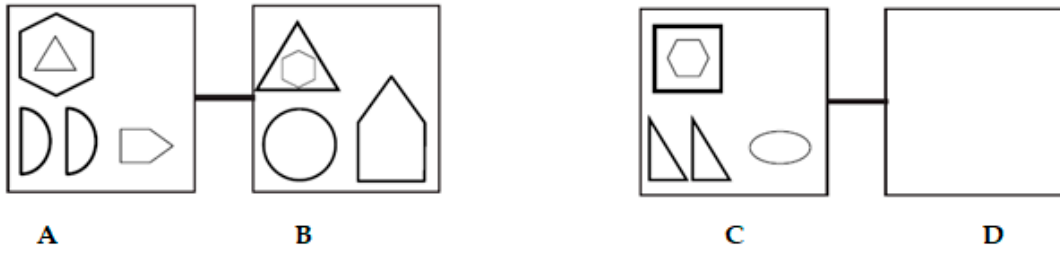
Figure 1. Example of a difficult analogy item.